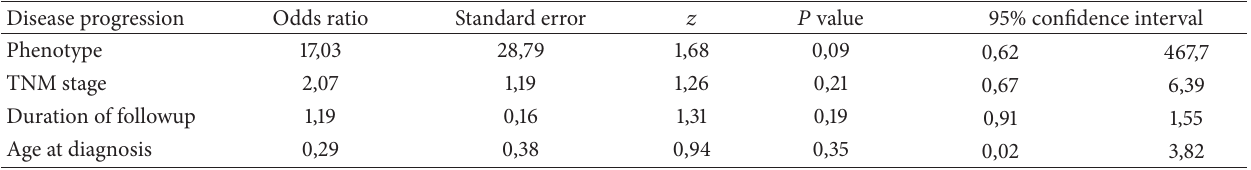
Table 1: Factors associated with the disease progression in patients with mycosis